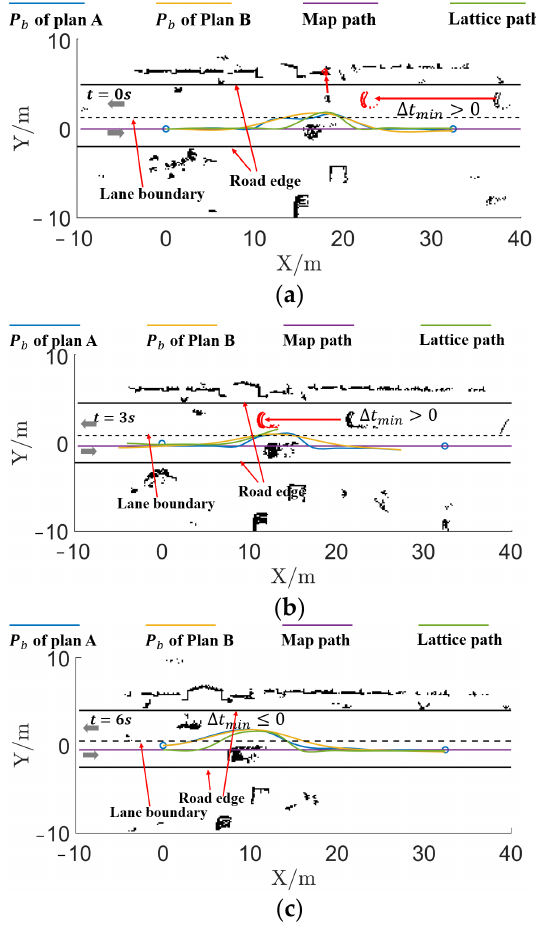
Figure 16. Dynamic scenario. ( a ) Planning result at time t = 0 s; ( b ) planning result at time t = 3 s;